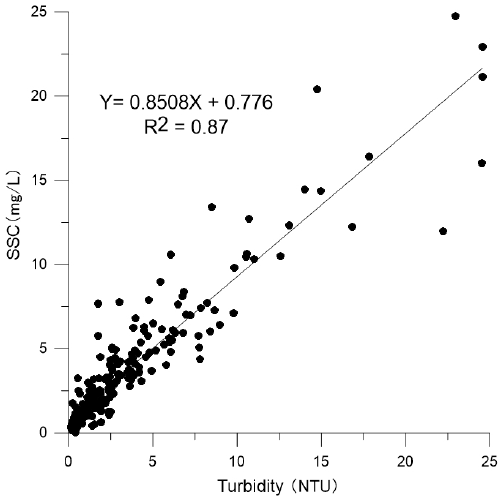
Figure 3. Relationship between measured SSC (mg/L) and measured turbidity (nephelometric turbidity units (NTU)). Figure 4 shows that the surface SSC has obvious linear relationships with the SSCs of the other layers. The correlation coefficient (R 2 ) gradually decreases from the surface layer to the bottom layer, but the lowest value is still above 0.84. The root mean square error (RMSE) gradually increases from the surface to the bottom and is nearly always below 3.3 mg/L (Table 2), which indicates an acceptable fit for this article. Table 2. Correlation of the fitting relationship between the SSCs of the surface layer and the other layers at the stations in the Bohai Strait.